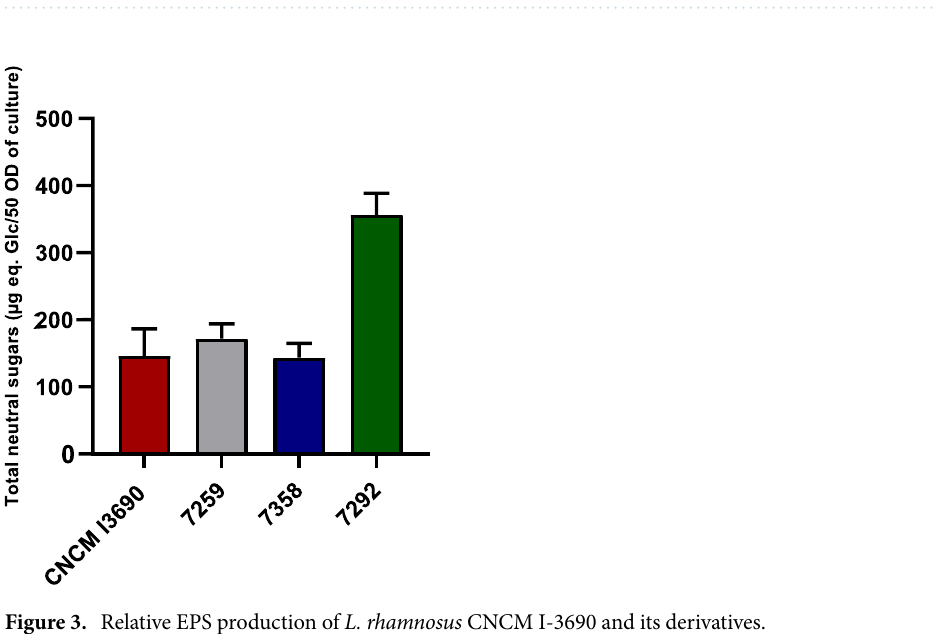
Figure 2. Immunomodulatory ( A ) and protective ( B ) activity of L. rhamnosus CNCM I-3690 and its variants. The immunomodulatory property is measured by the ability of the strains to regulate the production of interleukin 8 (IL-8) (%) by HT-29 cells stimulated with TNF-α. The protective effect is evaluated by measuring the trans-epithelial resistance in Caco-2 cells in the presence of the bacterial strains (b). Significance: * p < 0.05 (n = 3 × 3).